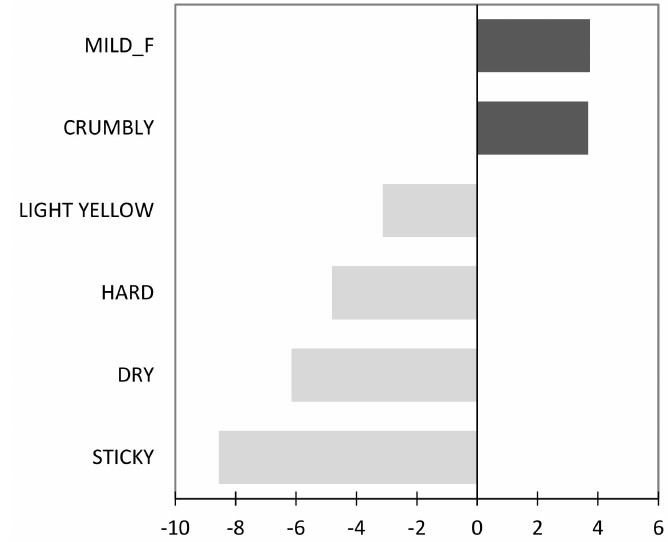
Figure 2. Penalty-lift analysis of sensory attributes across all snack samples. Only attributes that resulted in significant increase or decrease in overall liking are presented. (F =